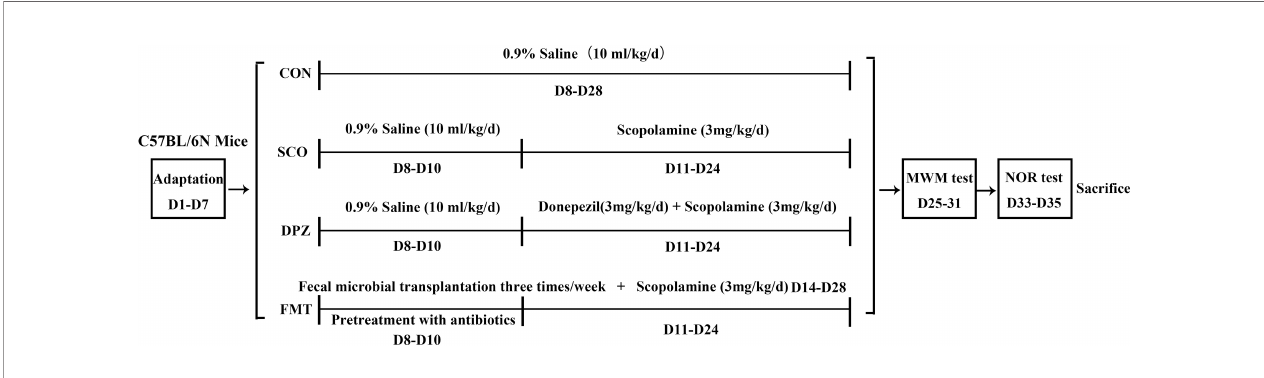
FIGURE 6 | The diagram for the experimental of